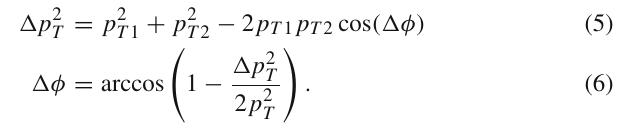
Fig. 10 Comparison of correlation functions C ((cid:2)φ) for the 5% most central Be + Be collisions and inelastic p + p interactions. Left column shows the correlation function for all charge pairs in Be + Be collisions at beam momentum 150 A GeV / c per nucleon. Middle column: the same